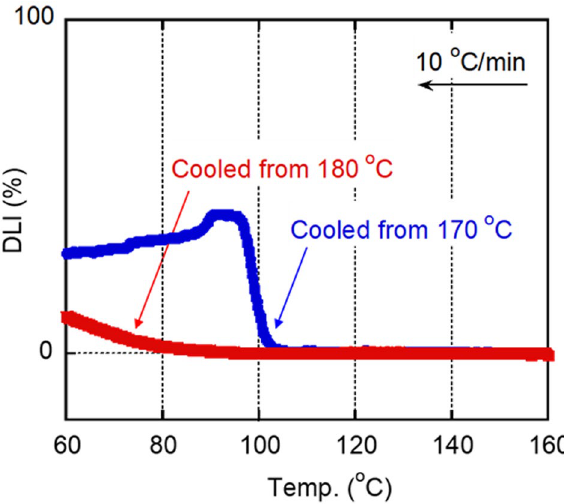
Figure 4. Growth curves of depolarized light intensity (DLI) during cooling at 10 °C min −1 . The sample had no shear history before